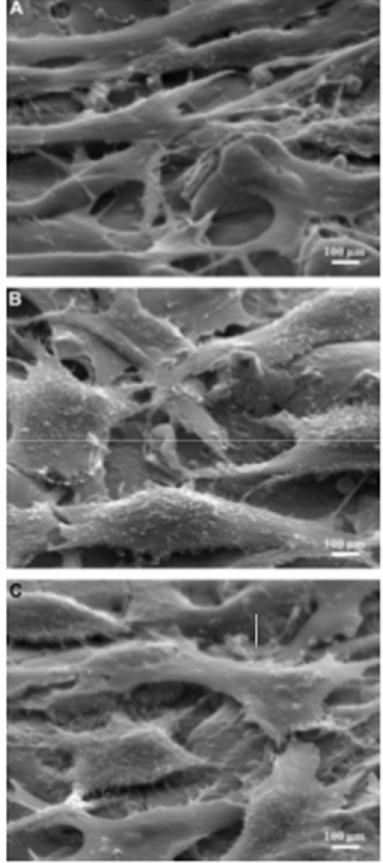
Figure 19. MG-63 cells attachment and proliferation after 7 days of cell culturing on the ( a ) untreated Ti64 specimen, ( b ) EDMed Ti64 specimen at 10 s pulse on-time, and ( c ) EDMed Ti64 specimen at 60 s pulse on-time [123]. (With kind permission from Elsevier).